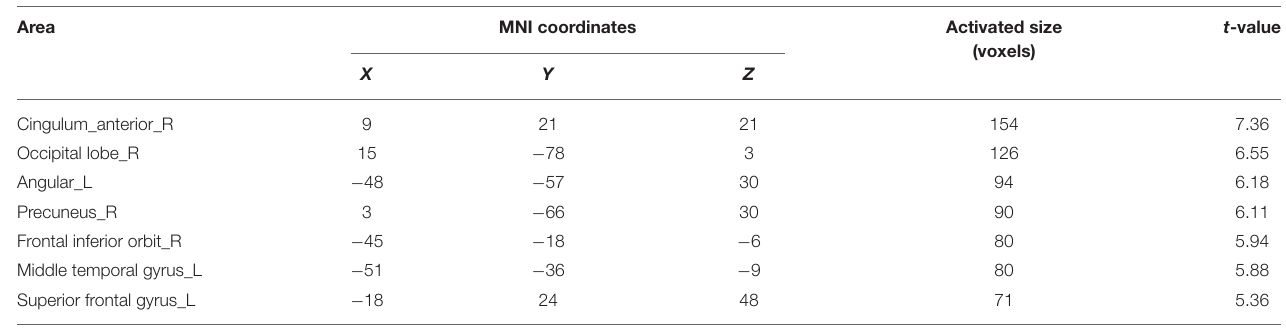
TABLE 3 | Brain activated regions responding to the UPO higher than PO in NC.